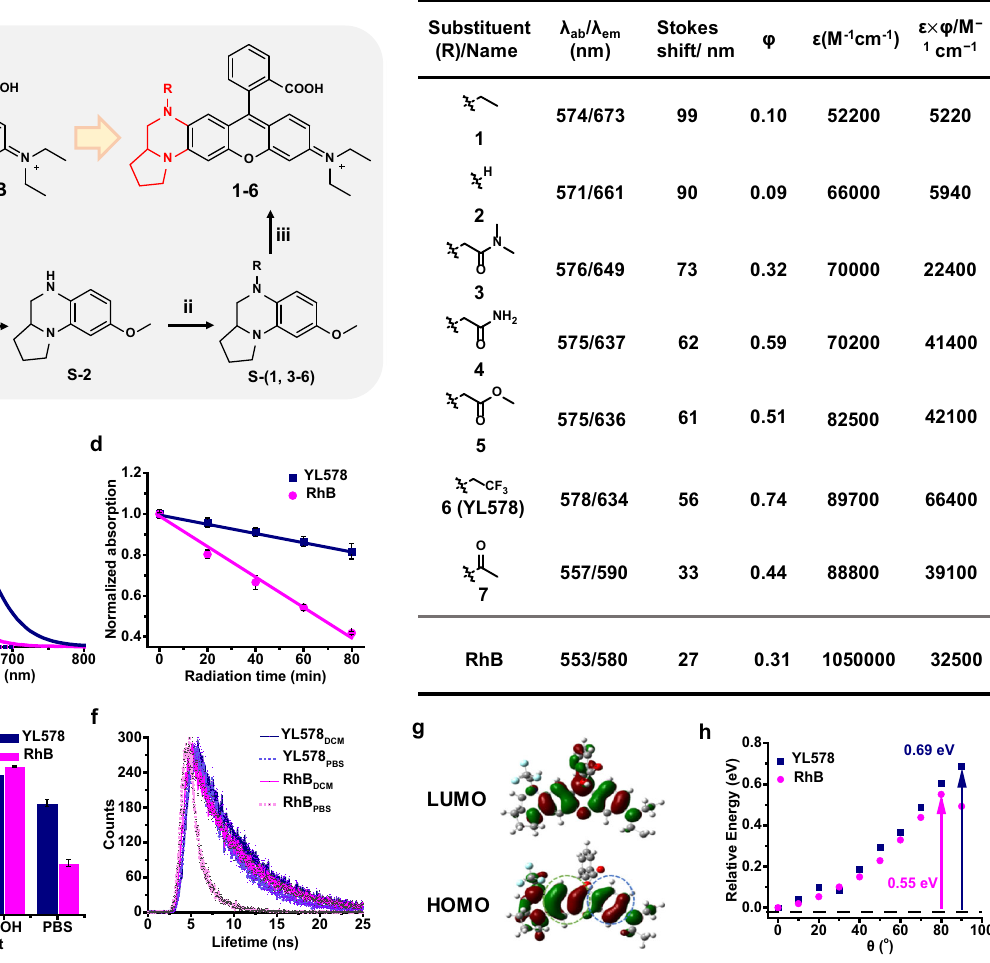
Fig. 2 Development of YL dyes. a Synthesis of rhodamine 1 – 6 . Reaction conditions: i) Proline methyl ester hydrochloride, triethylamine, acetonitrile, re fl ux, 12 h; methanol, zinc powder, 32% HCl, r.t., 30 min; tetrahydrofuran, NaBH 4 , boron tri fl uoride-diethyl etherate, re fl ux, 1 h; ii) For 2 – 5 , bromide, K 2 CO 3 , acetonitrile, 90 °C, 2 h; for 6 (YL578) , tri fl uoroacetic anhydride, tetrahydrofuran, room temperature, 10 min; sodium borohydride, boron tri fl uoride etherate, re fl ux, 1 h; iii) 2-(4-Diethylamino-2-hydroxybenzoyl)benzoic acid, methanesulfonic acid, 90 °C, 2 h. The moiety in red indicates the difference between YL dyes and Rhodamine B. b The photophysical properties of 1 – 7 in aqueous solution. λ abs , absorption at λ max ; ɛ , extinction coef fi cient; λ em , emission at λ max ; φ , quantum yield; ɛ × φ , brightness. c Normalized absorption and emission spectra of YL578 and RhB. d Absorption at λ max of YL578 and RhB was plotted as a function of irradiation time with a laser (1 W) at 530 nm. Solution concentrations were adjusted to be comparable to one another in terms of optical density at 530 nm. Error bars, ±s.e.m. n = 3. e Normalized fl uorescence maxima intensities of YL578 and RhB in various solvents. Error bars, ±s.e.m. n = 3. f Fluorescence lifetime of YL578 and RhB in DCM and PBS. g DFT optimized HOMO and LUMO orbital plots of YL578 . h Calculated potential energy surfaces of YL578 and RhB in